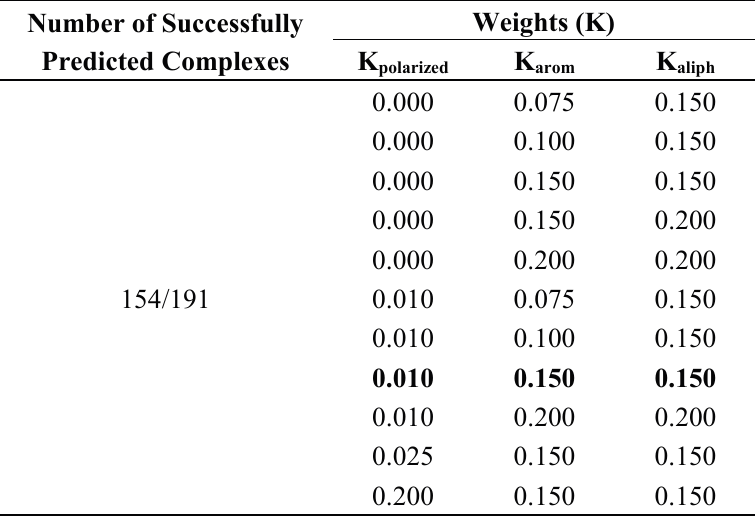
Table 3. Triplets of weights which lead to the best rescoring results (the selected triplet is shown in bold).